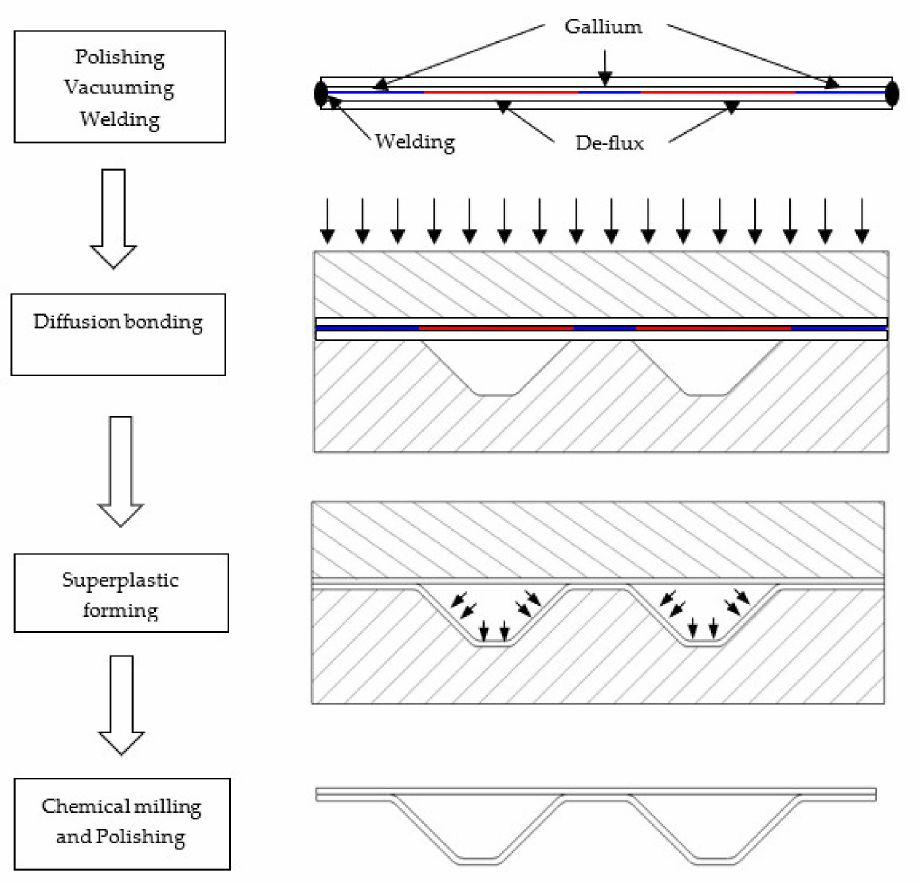
Figure 3. Preparation process of the two-layer hollow structure of the 1420 Al-Li